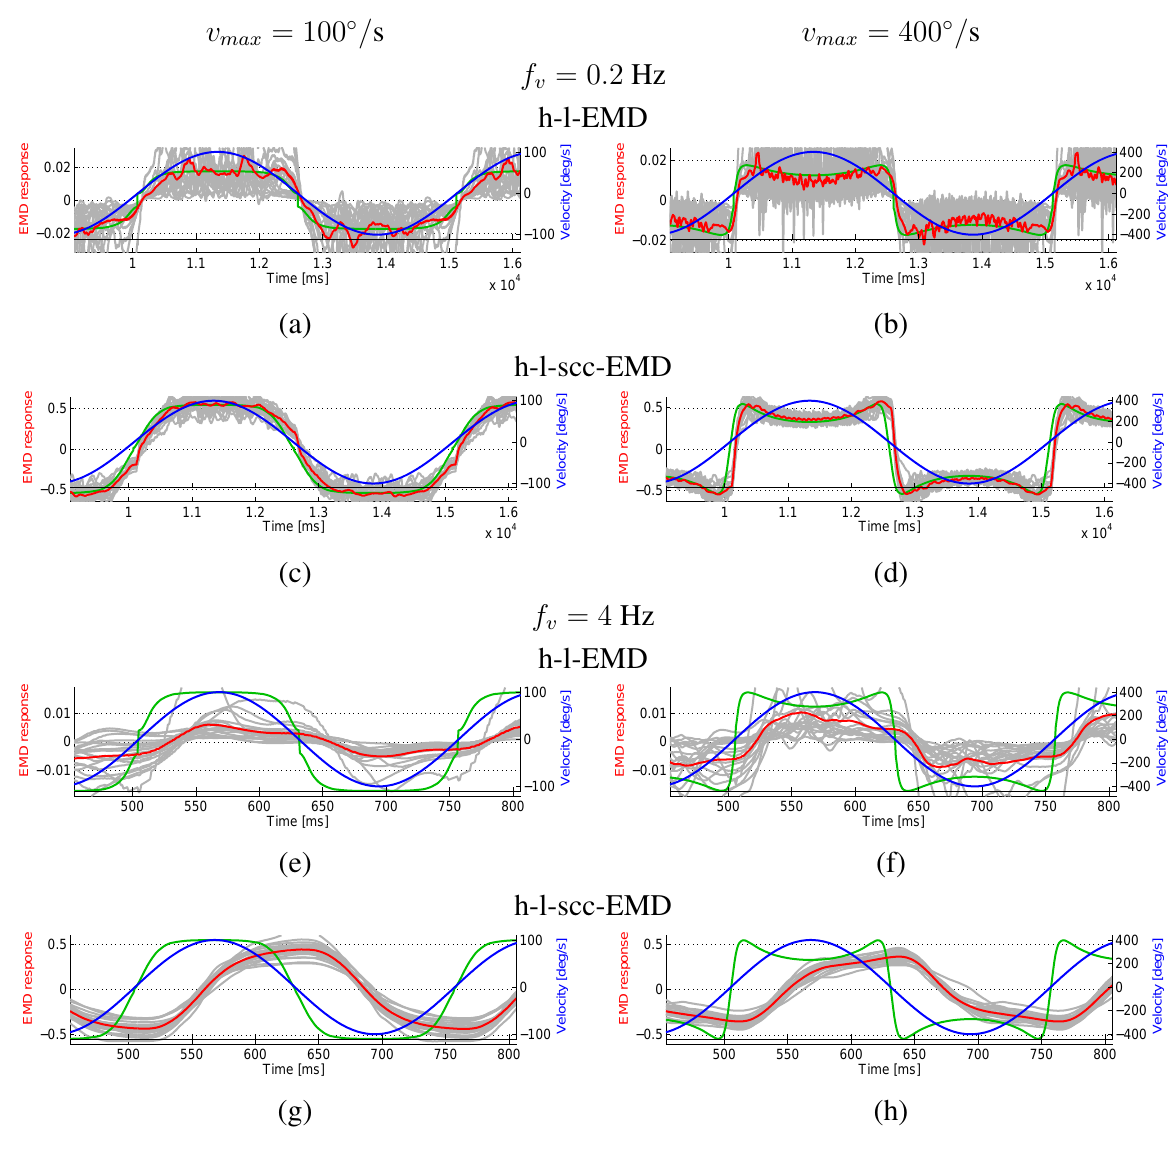
Figure 12. Responses of the EMD arrays to dynamic stimulation. Blue curves and right scales show the stimulus velocity versus time, red and grey curves and left scales show the responses. Grey lines represent individual simulation results, red lines average results for 4 panorama images and 5 different starting positions. The green curves show the theoretical response predicted from the steady state response curves derived from the previous tests. The velocity of panorama images was oscillated sinusoidally at 0.2 Hz (a–d) or 4 Hz (e–h). The peak velocity was 100 ◦ / s (left column) or 400 ◦ / s (right column). Responses of two model variants are shown: h-l-EMD (a,b,e,f) and h-l-scc-EMD